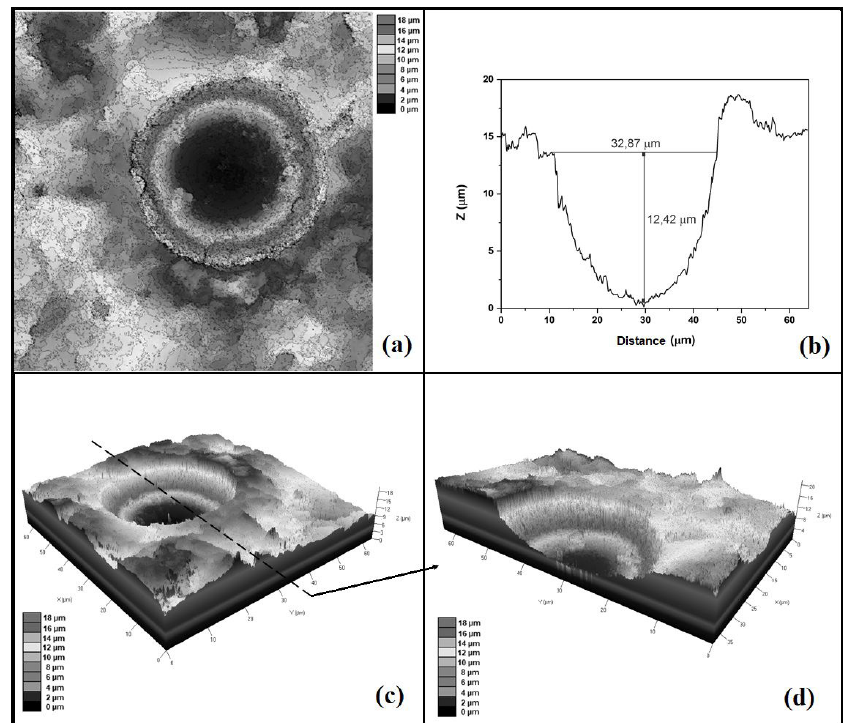
Figure 7. Pit formed on the surface of the X80 steel coupon after 45 days of exposure to the biotic system. In (a) 2D analysis, (b) profile of the pit, (c) 3D topography and (d) cross section of the pit in